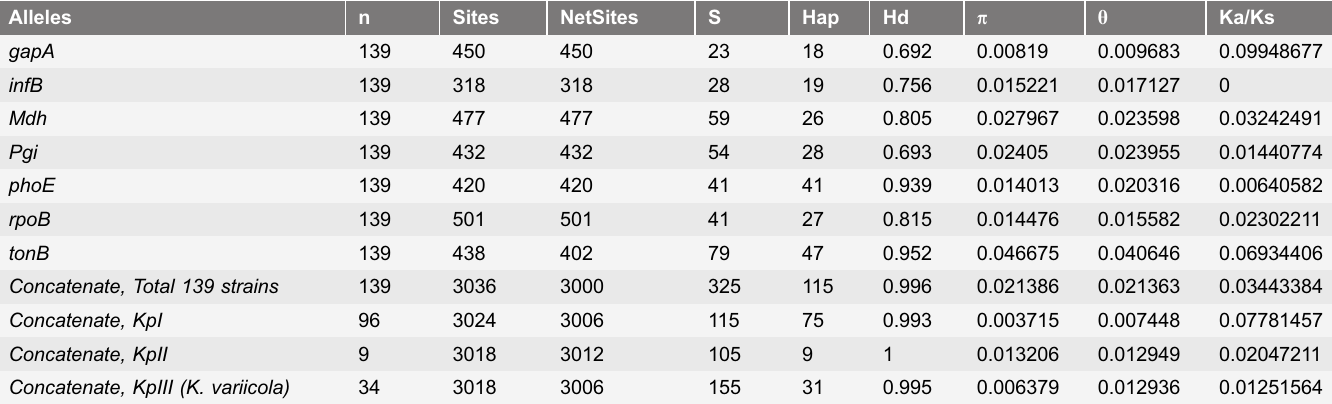
Table 1. Nucleotide polymorphism within the seven housekeeping genes used for MLST